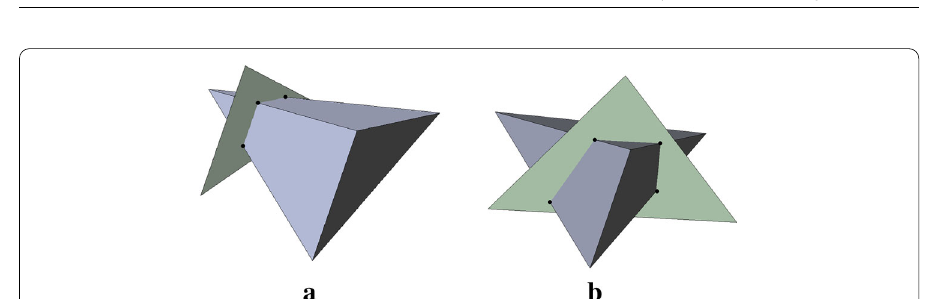
Fig. 10 Relevant intersection patterns for an immersed plane face. a Three intersection points. b Four intersection points